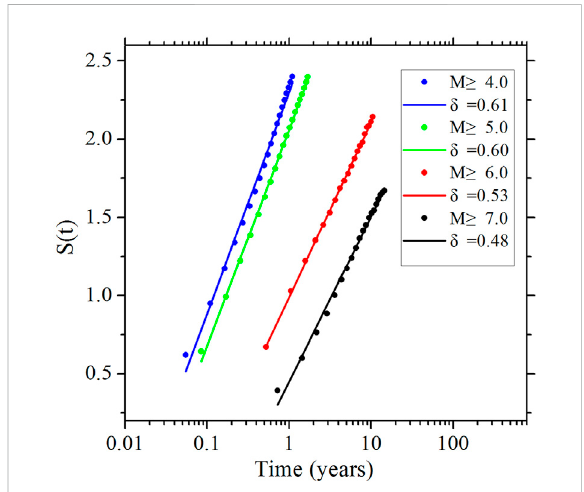
FIGURE 3 Variationofdiffusionentropyofearthquakeswithtimeandits scale value in Taiwan region. The dots in the fi gure represent entropy based on actual data, and the lines are the fi tted Shannon entropy function based on time.